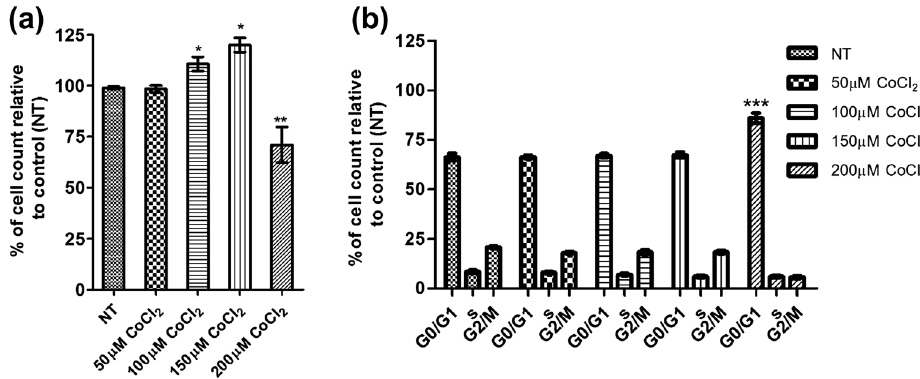
Figure 2. Effect of CoCl 2 on cell viability and cell cycle. Primary ovarian cancer cells were either not treated (NT) or treated with different concentrations of CoCl 2 (50,100,150 and 200 µM) for 48 h. Cells were stained with Hoechst 33342 and scanned and analysed using the Cytell imaging system and Cell Cycle BioApp software. ( a ) Viable cells were automatically counted and data were presented as mean ± SEM (n = 3) and were analysed using one ‐ way ANOVA with Tukey’s post-hoc test, “*” p < 0.05. ( b ) Cell cycle distribution was analysed using the cell cycle Bioapplication. Data were presented as mean ± SEM (n = 3). 2-way ANOVA with Bonferroni post-test analysis was carried out on the experimental data, with respect to the corresponding controls, and statistically, significant data is reported by *for p < 0.05; ** for p < 0.01 and *** for p < 0.001.